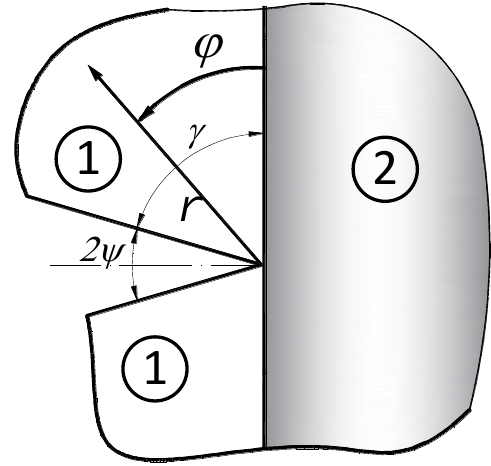
Figure 1. A notch terminating at a bi–material interface.